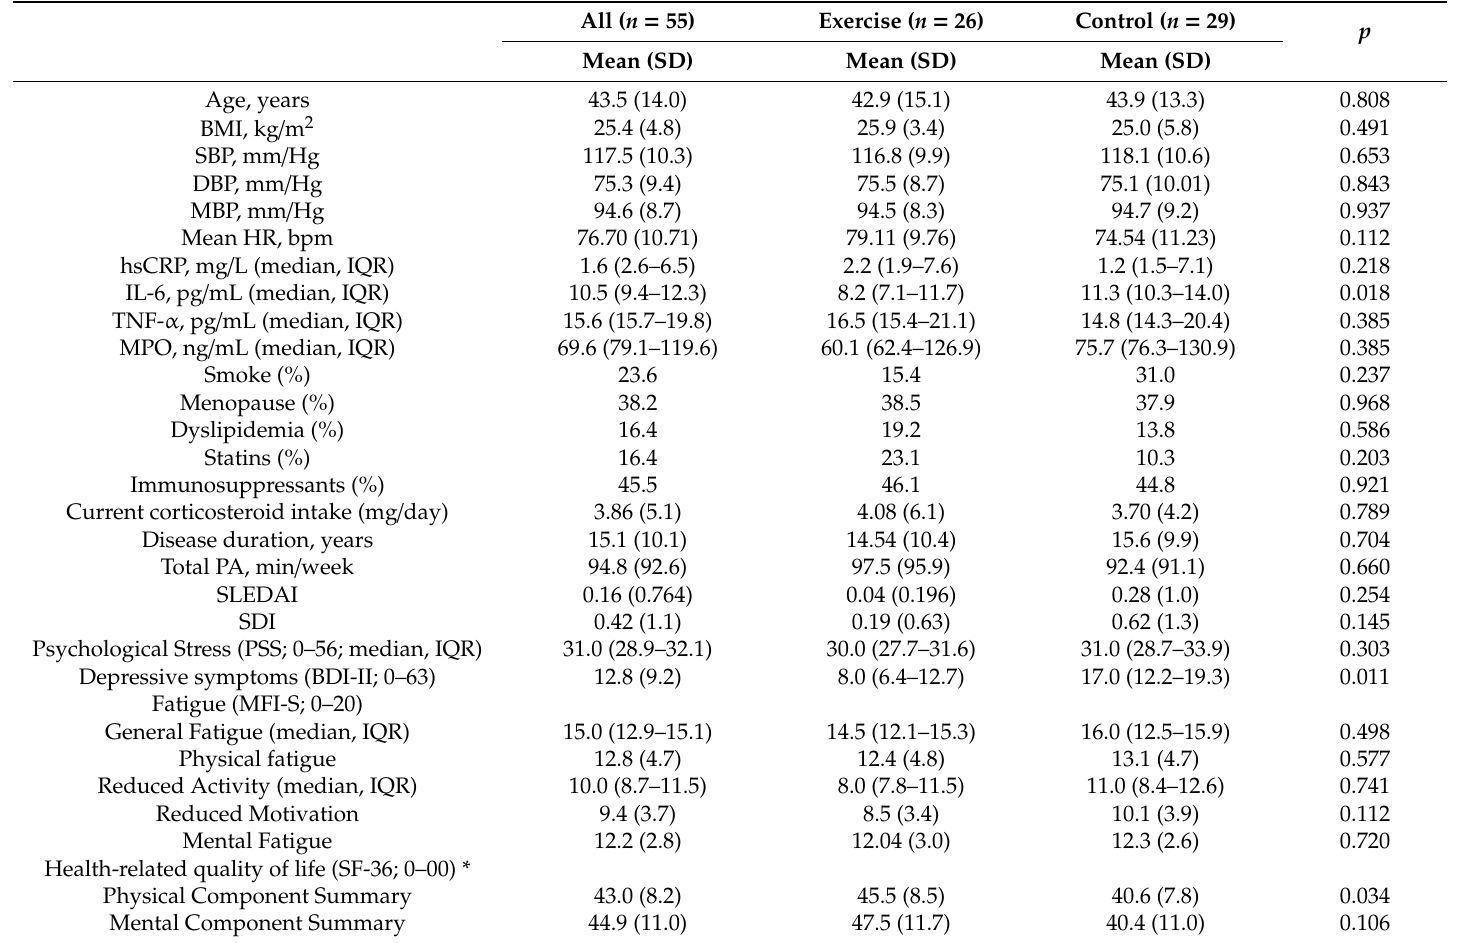
Table 1. Baseline characteristics of the study